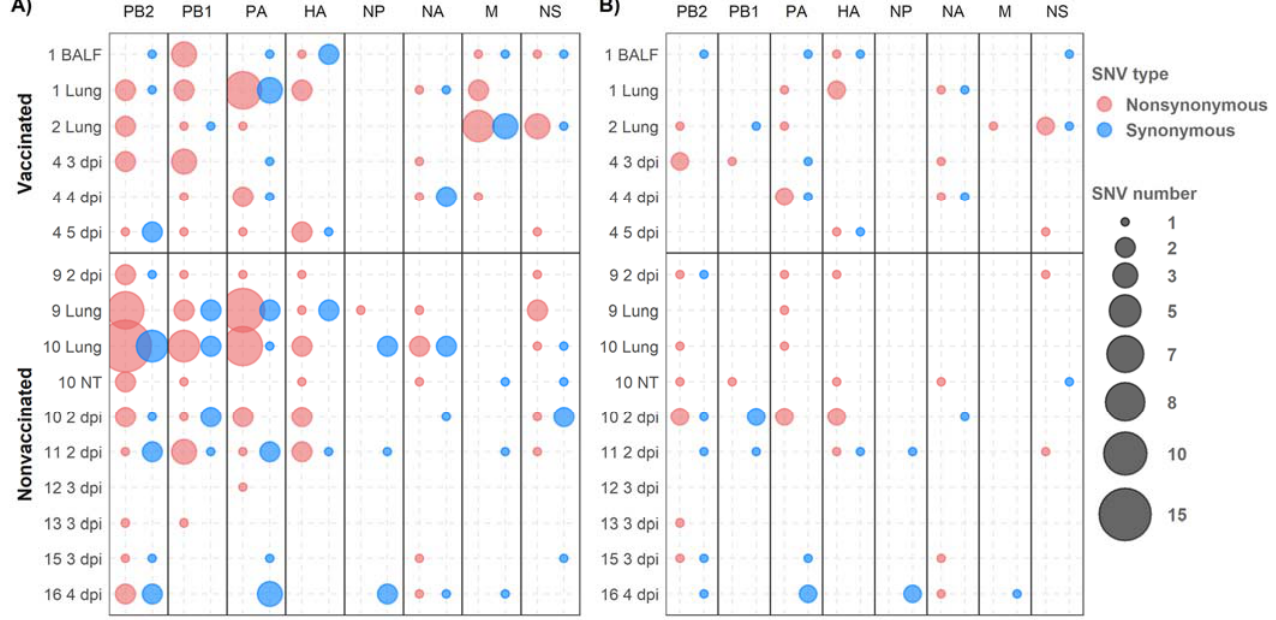
Figure 7. De novo synonymous and nonsynonymous SNV allocation. Nonsynonymous and synonymous variants are represented in red and blue, respectively. Circle size indicates the total number of substitutions found per genomic segment (abscissa axis) and sample (ordinate axis). ( A ) SNVs with an allele frequency greater than 1%. ( B ) SNVs with an allele frequency greater than 5%.